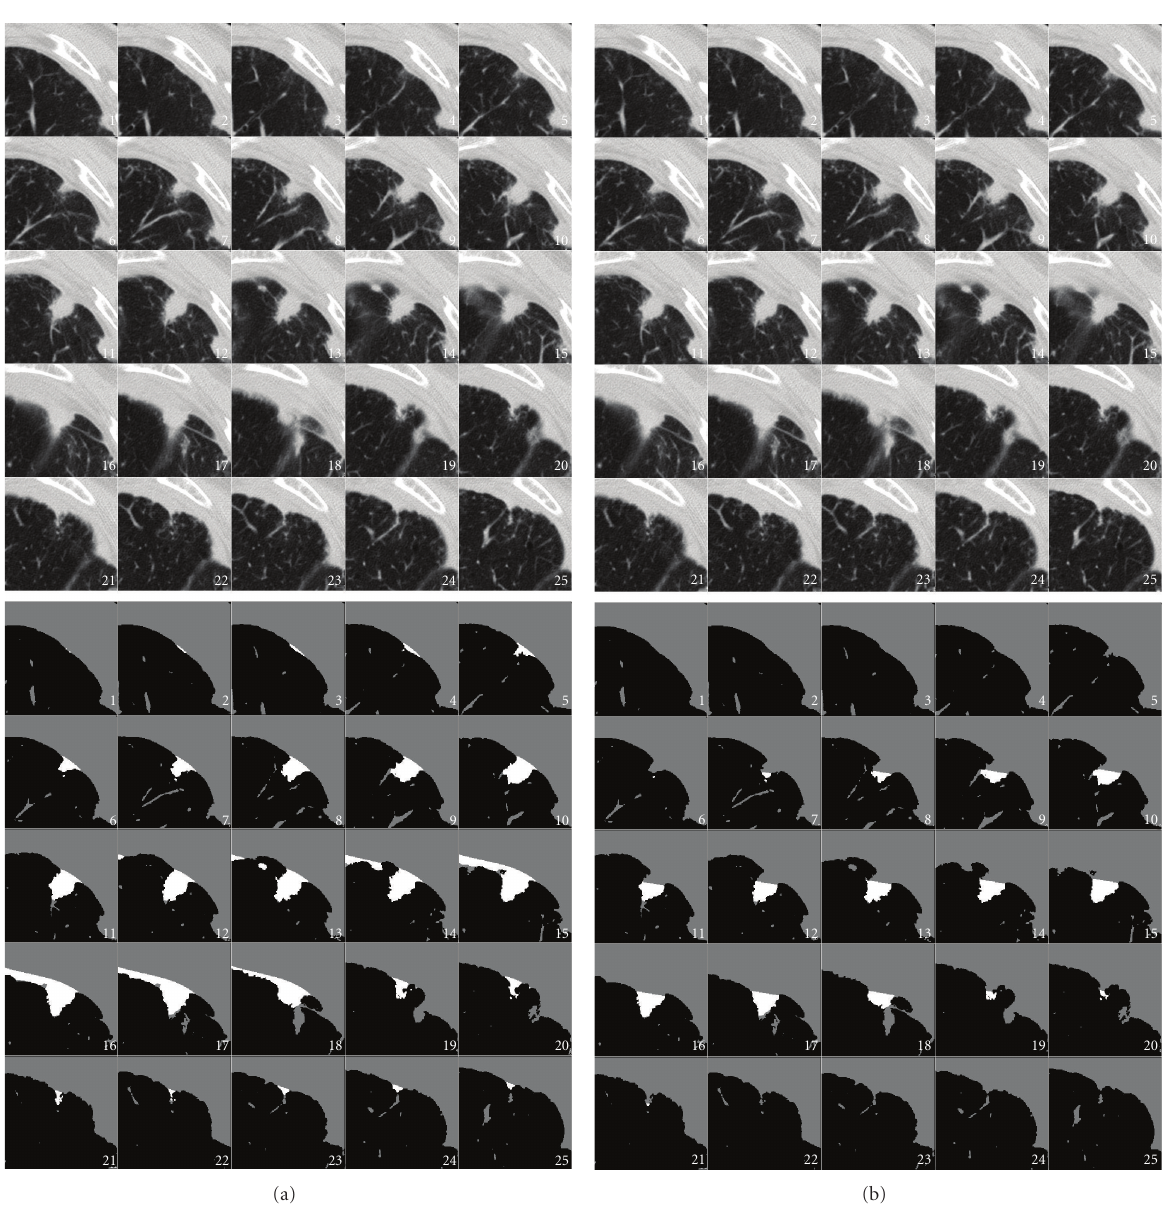
Figure 17: Example of a nodule for which both algorithms segmented a portion of the wall due to respiratory motion in frames 13–18. The voxels included in the segmentation are labeled in white for the (a) surface-fitting method and (b) plane-cutting